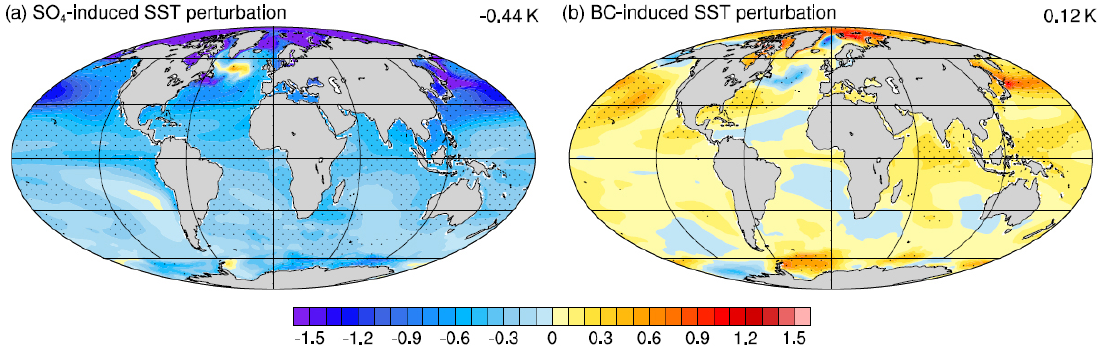
Figure 3. Annual mean distributions of SST responses to (a) SO 4 and (b) BC forcings (unit: K). The dots represent significance at ≥ 95% confidence level from the t